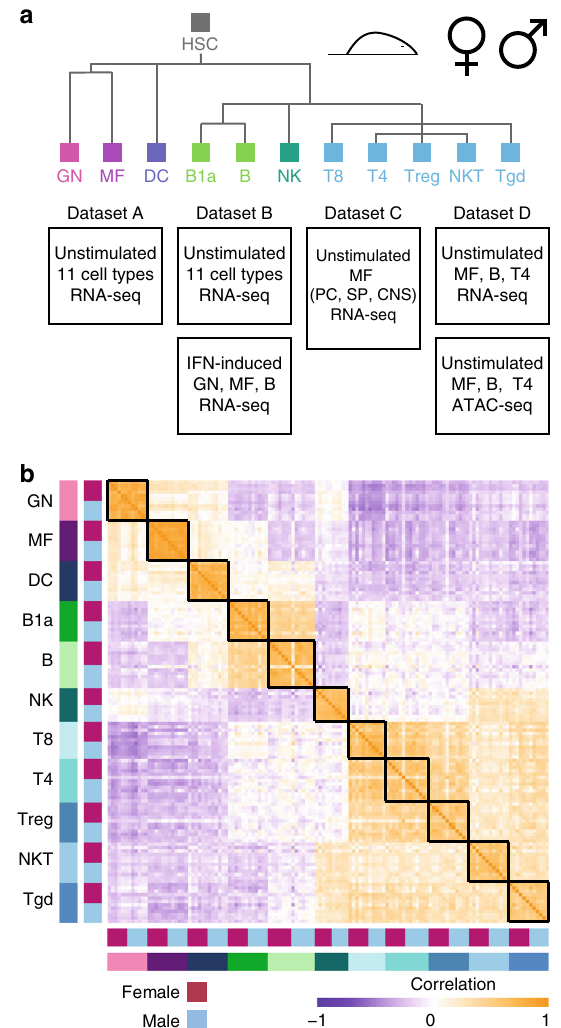
Fig. 1 Cell-type transcriptional signature masks the sex effect. a Overview of the datasets used in this study. All four datasets include samples from male and female mice, from some or all of ImmGen 11 cell set, whose cell types are shown in the tree on the top. On the bottom, details of the four datasets used. PC peritoneal cavity, Sp spleen, CNS central nervous system, ATAC-seq Assay for Transposase-accessible Chromatin, GN granulocytes, DC dendritic cells, MF macrophages, T4 CD4 + T cells, T8 CD8 + T cells, Treg regulatory T cells, NK natural killer cells, NKT natural killer T cells, Tgd gamma delta T cells. b Pearson correlation matrix of the samples comprising datasets A and B (including the entire 11 cell set) for the 2904 genes that are expressed in both datasets, sorted by cell type and sex. Black rectangles mark samples of the same cell type. Source data for b are provided as a Source Data fi